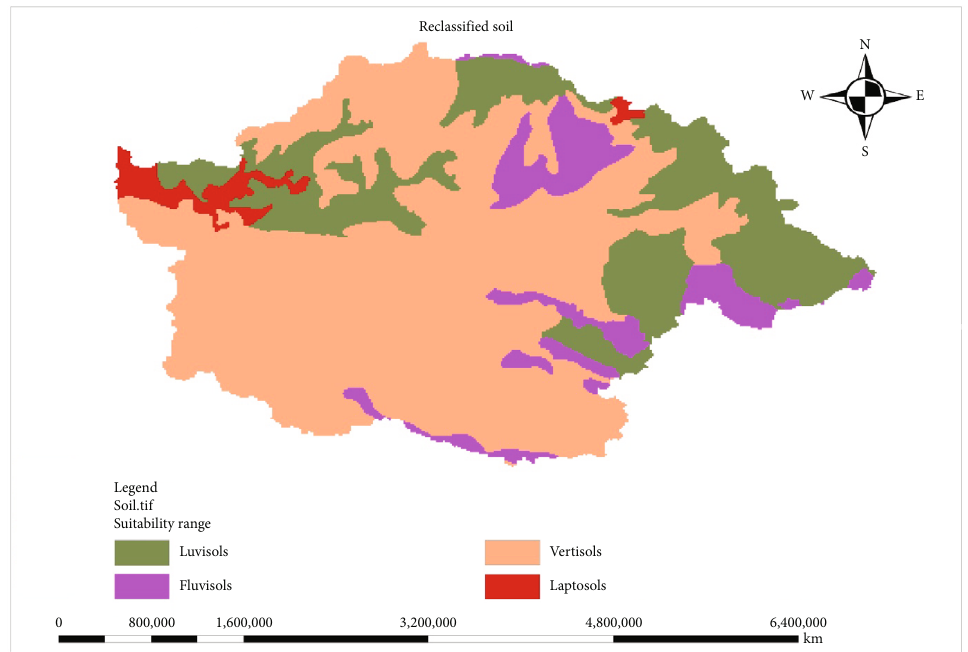
Figure 10: Suitable soils for solar